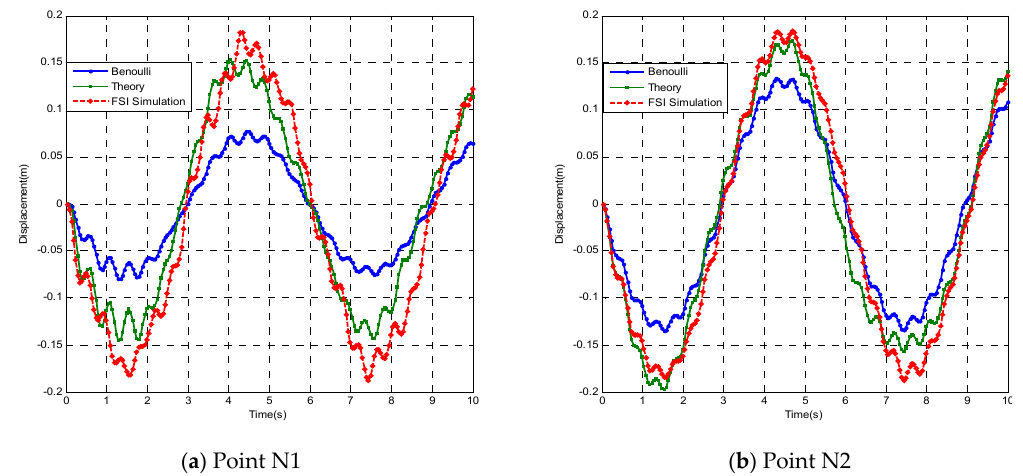
Figure 12. The time history of the X-direction displacement at the point of N1 and N2.